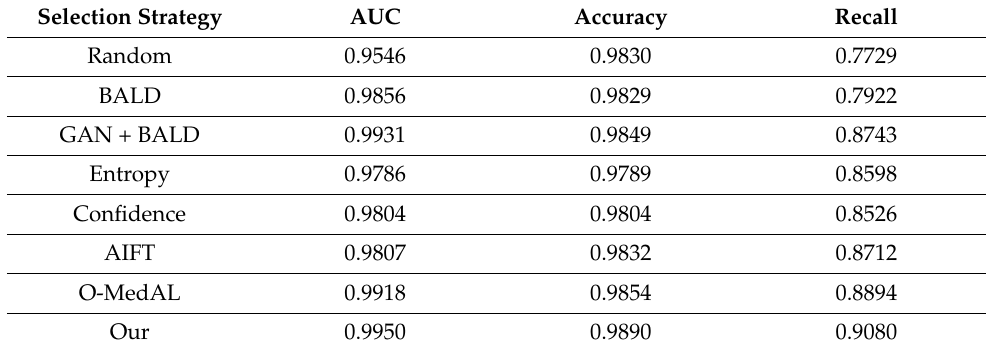
Table 2. Performance of different strategies at the end of the iterative process.